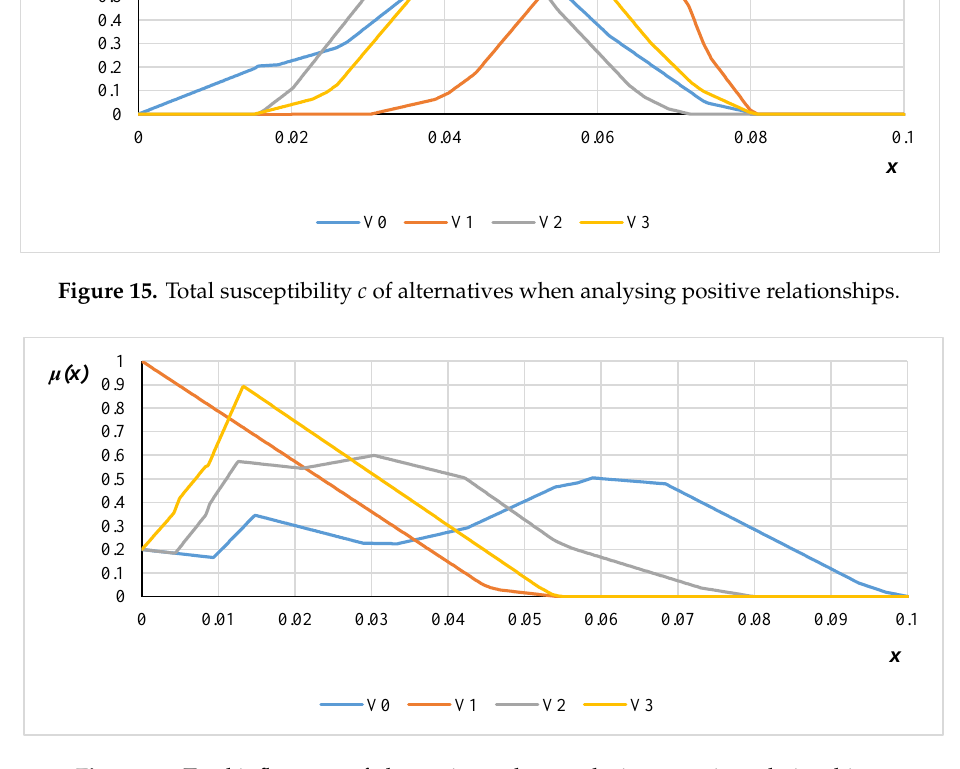
Figure 16. Total influence r of alternatives when analysing negative relationships.